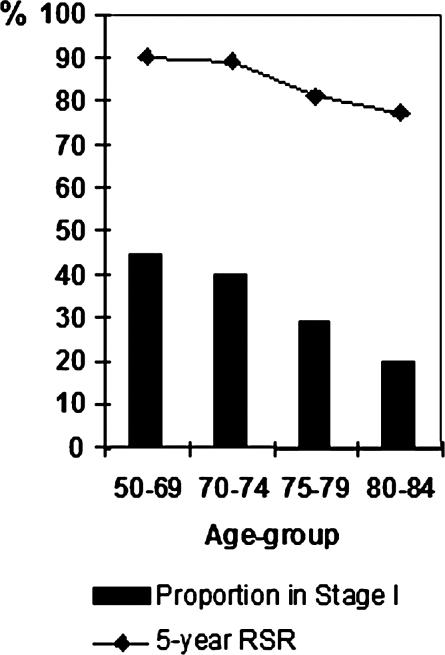
The proportion of women diagnosed in stage I breast cancer and the 5-year cumulative relative survival ratio differ by age group.